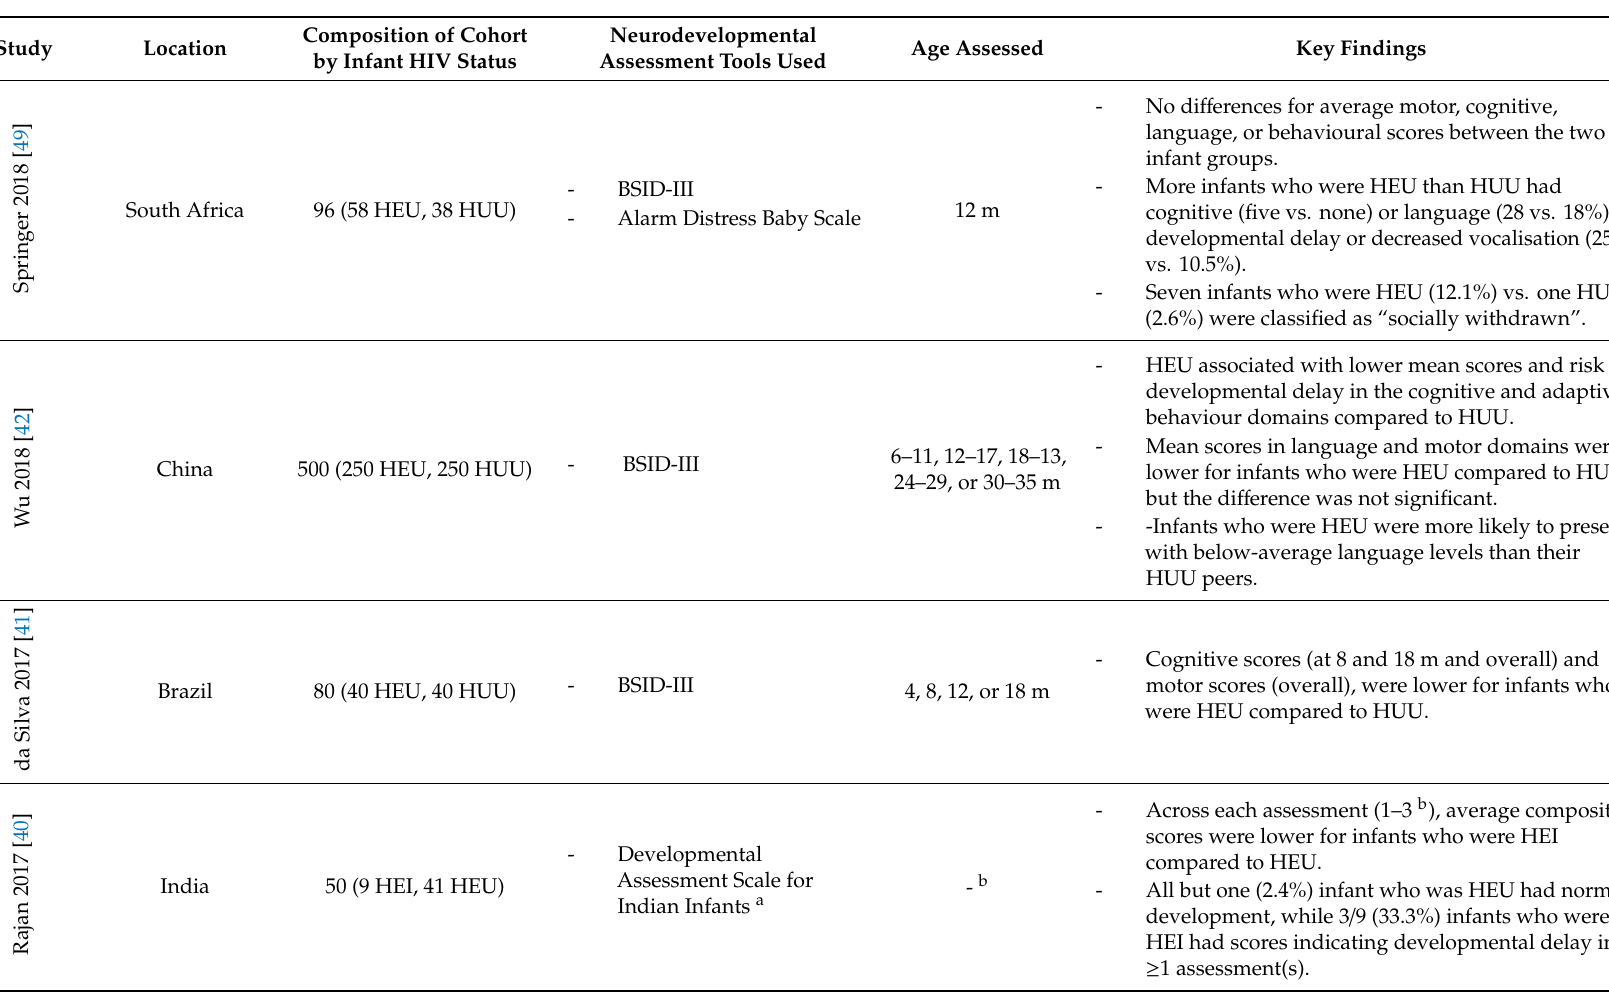
Table 1. Summary of key findings on neurodevelopmental outcomes from birth to 36 months of age in infants born to mothers living with